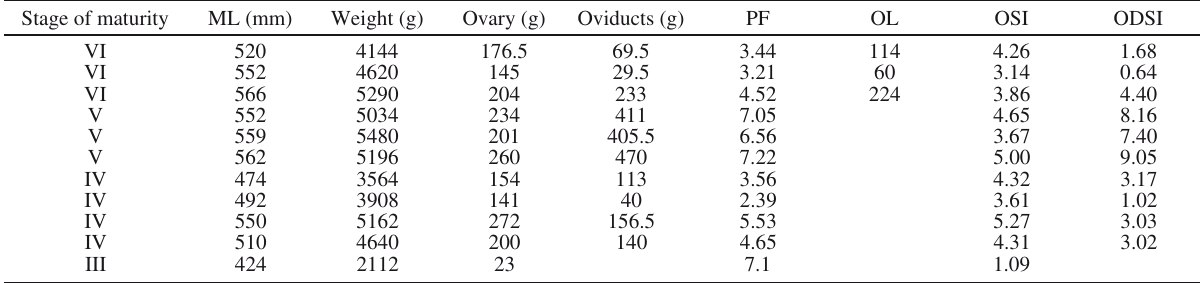
Table 4. – Means of potential fecundity (PF, in millions), oviductal load (OL, in thousands), Ovary index (OSI, in %), and oviduct index (ODSI, in %) of O. bartramii collected in 2013 around the Hawaii region. Stage of